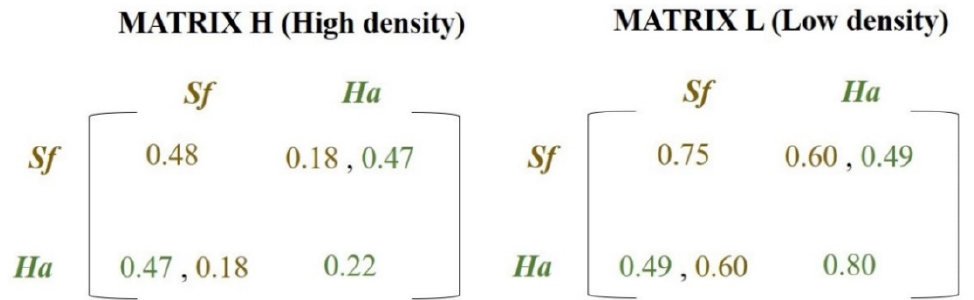
Figure 1. Payoff matrices containing the survival probabilities of Helicoverpa armigera ( Ha ) (green values) and Spodoptera frugiperda ( Sf ) (brown values). The matrices represent the payoffs given the inter + intraspecific interactions (principal diagonal) or only interspecific interactions (secondary diagonal) for states with high population densities ( MATRIX H ( High density )) or low population densities ( MATRIX L ( Low density )). These results were obtained in the biological experiments and they are expressed in Figure 2 A – C (Results section). (For a color version of this figure, the reader is referred to the web version of this article.).